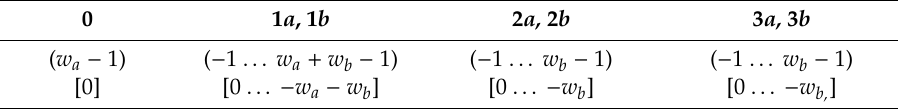
Table 3. Increments of T and P when circularizing a chain by joining